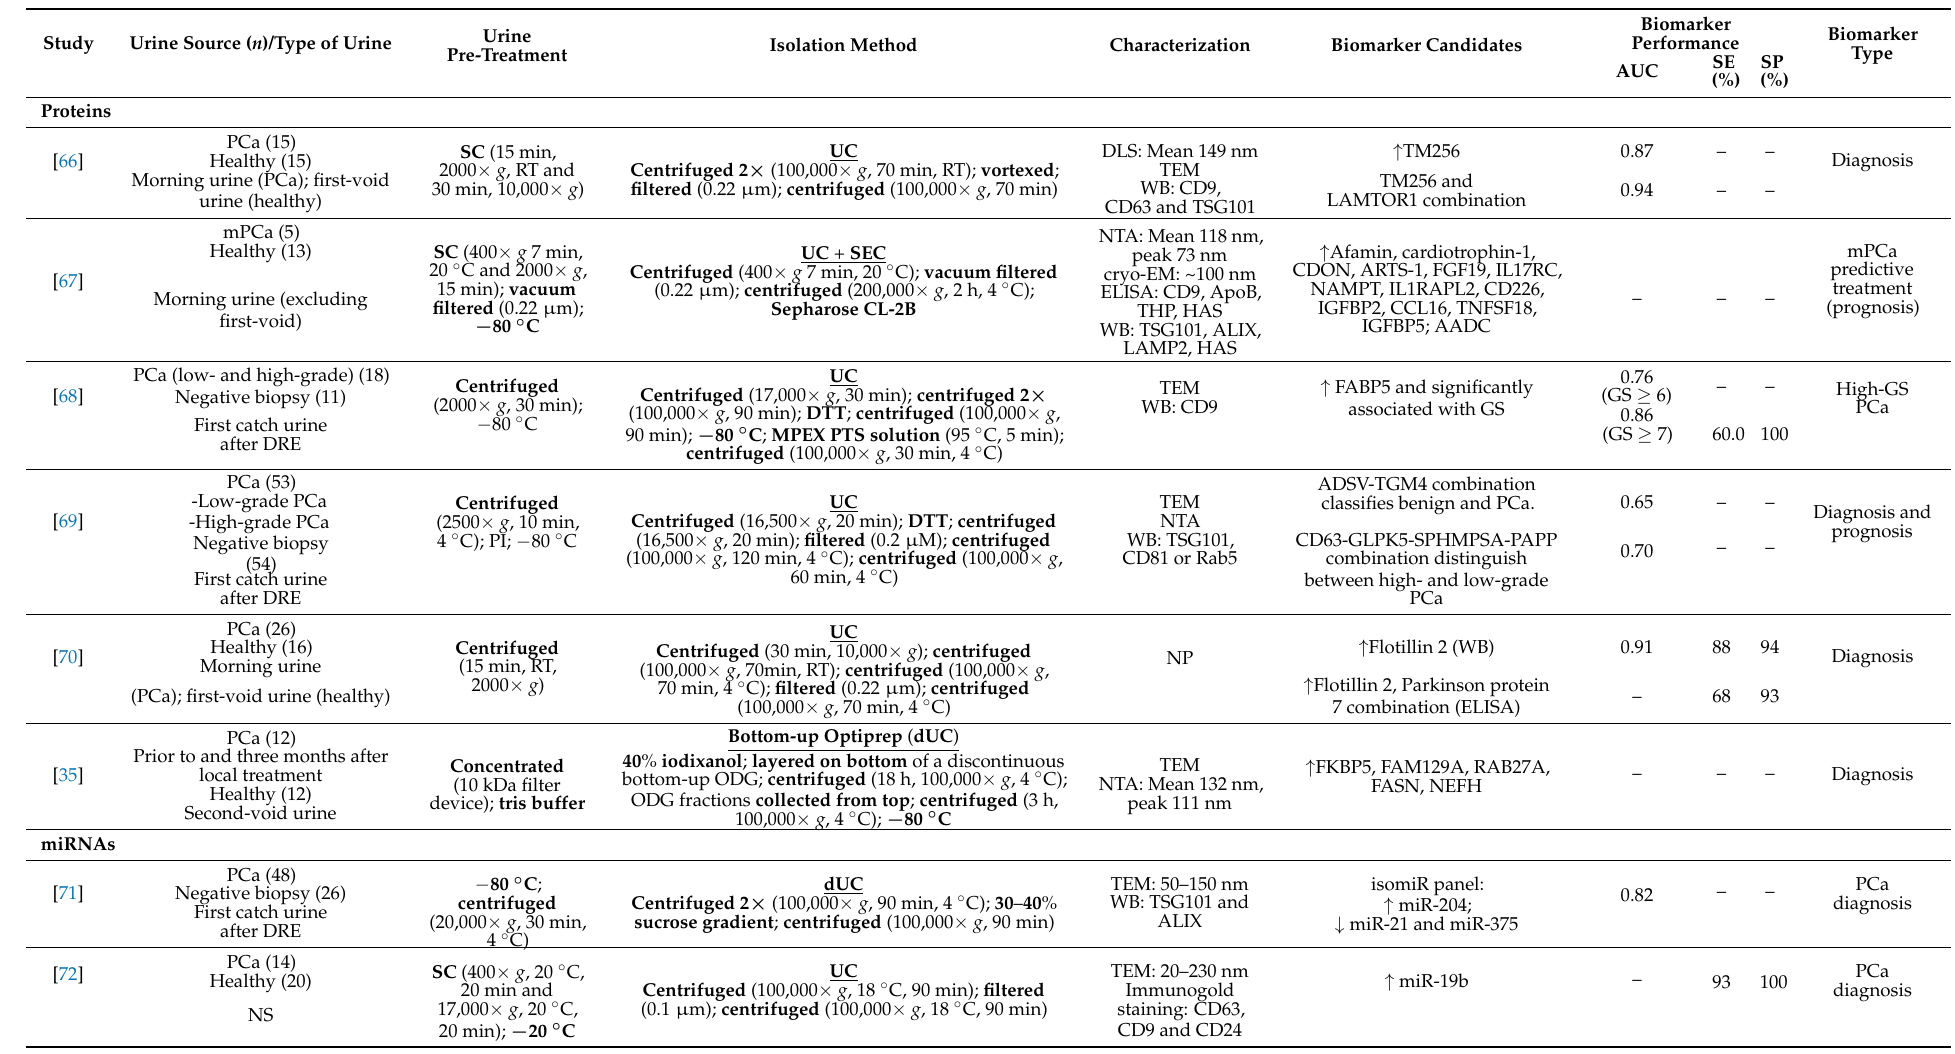
Table 2. uEV-derived protein and miRNA biomarker candidates in prostate cancer